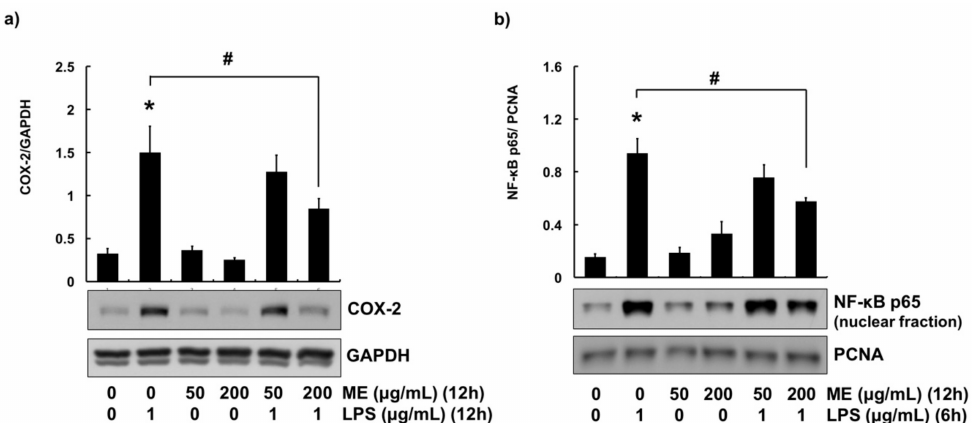
Figure 3. COX-2 expression and NF- κ B activation in cells treated with moringa extract (ME). ( a ) Cells were pre-treated with ME (50 and 200 µ g / mL) for 12 h followed by LPS treatment (1 µ g / mL) for 12 h. Western blot analysis was used to measure COX-2 expression levels in whole cell lysates. GAPDH was used as a loading control. ( b ) Cells were pre-treated with ME (50 and 200 µ g / mL) for 12 h followed by LPS treatment (1 µ g / mL) for 6 h. Nuclear translocation of NF- κ B p65 was determined using nuclear fraction and Western blot analysis. PCNA was used as a loading control. Western blots shown are representative images of three independent experiments. Values represent means ± SEM ( n = 3). *,